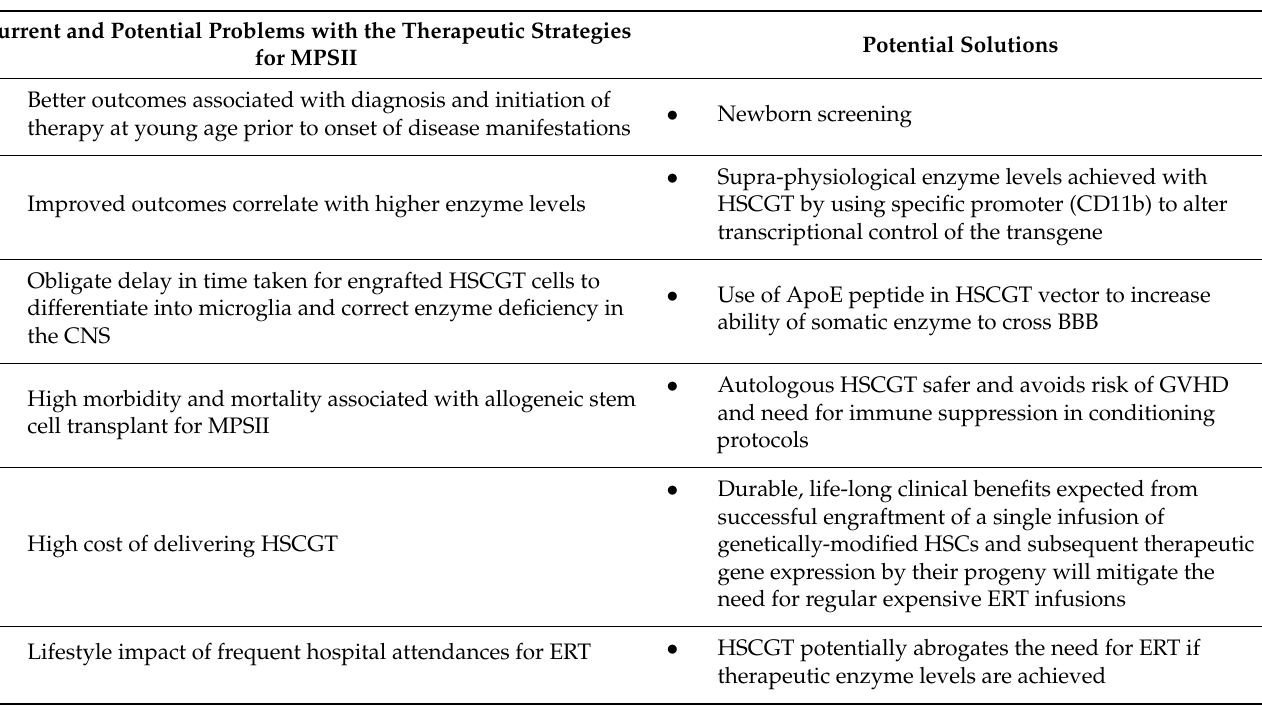
Table 2. Current and potential problems with the therapeutic strategies for MPSII alongside poten- tial